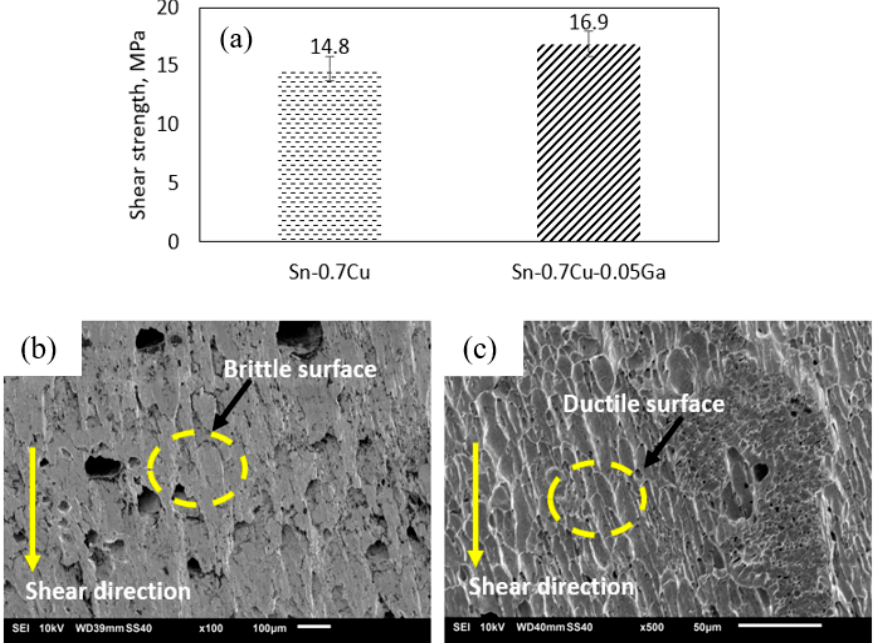
Figure 14. Graph of ( a ) shear strength and SEM fracture surface image of ( b ) Sn–0.7Cu/Cu and ( c ) Sn–0.7Cu–0.05 wt.%